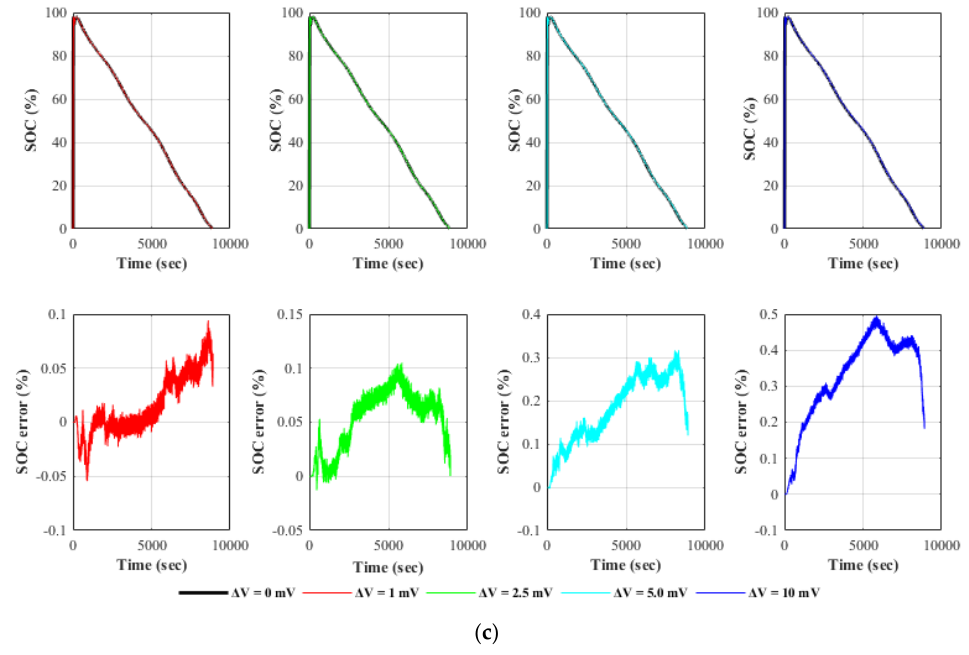
Figure 9. Estimated values at different precision of voltage sensors: ( a ) model parameters; ( b ) estimated OCV; ( c ) estimated SOC.